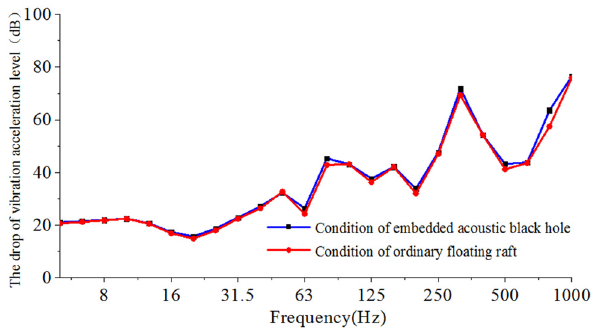
Figure 19: 1/3 octave curve of the vibration level